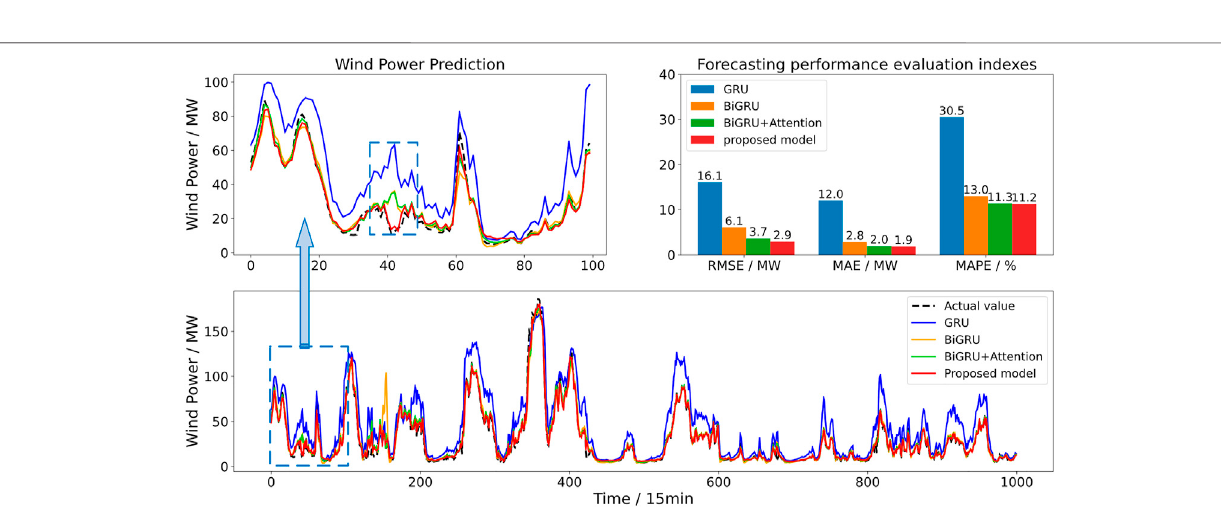
FIGURE 7 | Partial prediction results and prediction error indexes of different models of the whole wind